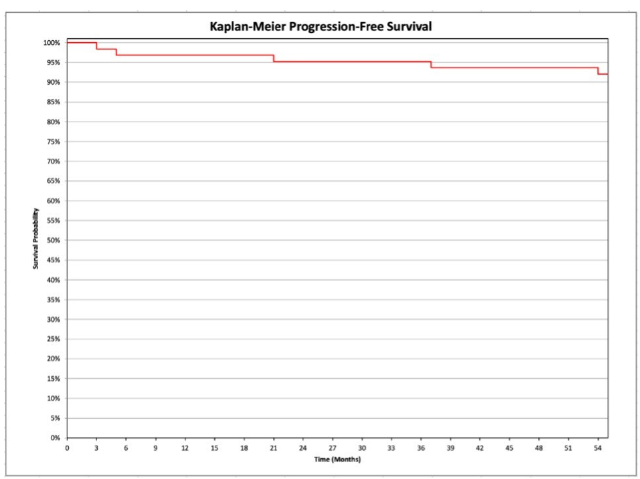
Figure 1. Kaplan-Meier analysis of the progression free survival in the investigated population (women affected by in endometrioid ovarian cancers, and by synchronous endometrial-ovarian endometrioid cancers).